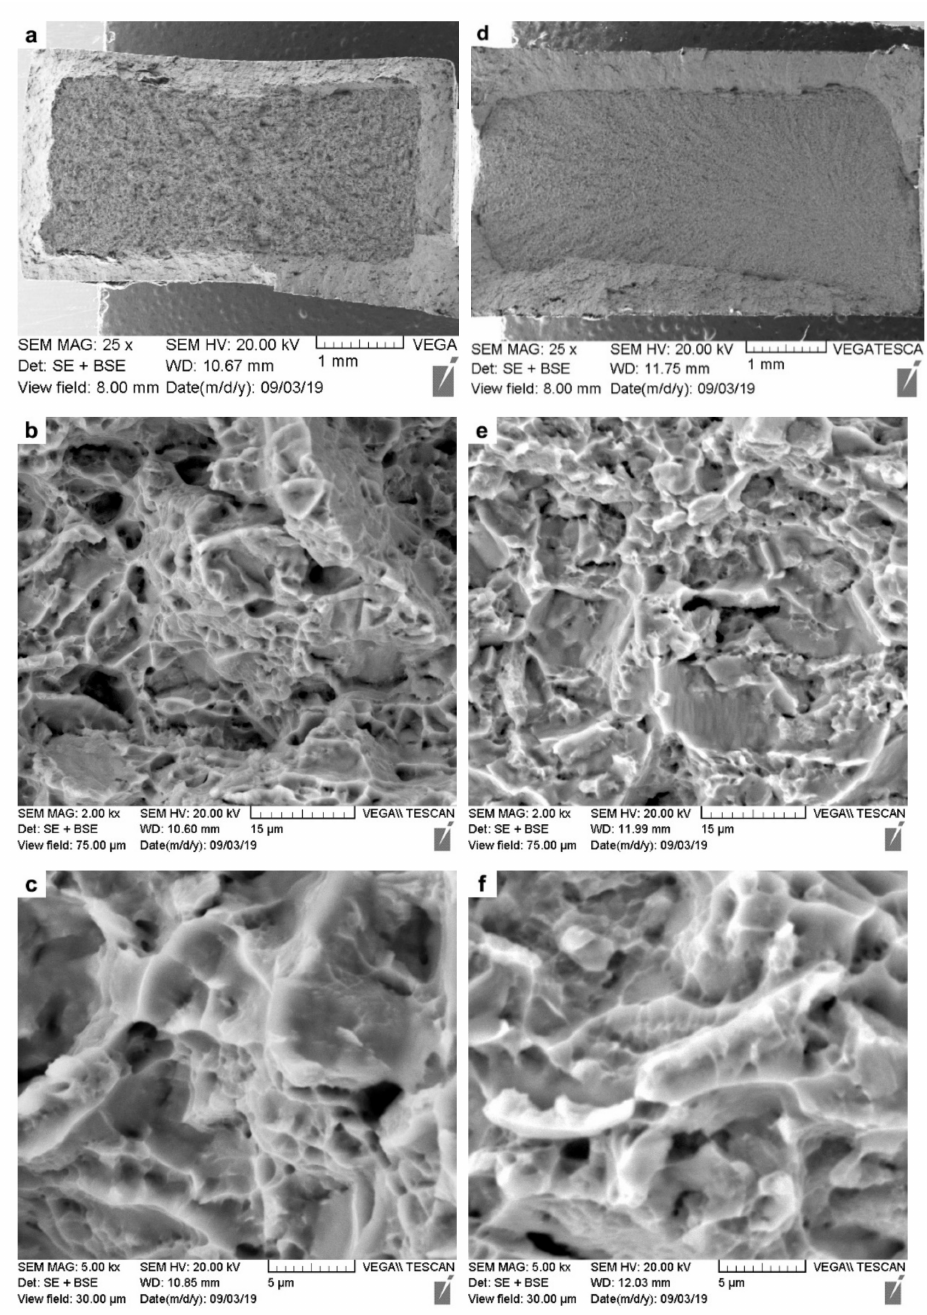
Figure 11. SEM images of the tensile fracture surfaces: ( a – c ) AWed; ( d – f ) SRAed. At high magnification, images of the fracture surfaces from the AWed (Figure 11b,c) and SRAed joints (Figure 11e,f) show evidence of ductile fractures with the presence of dim- ples that are a result of microvoid formation, growth, and coalescence. Specifically, in the absence of precipitates/inclusions, the mismatch in the strain hardening characteristics of α and β phases in Ti-6242 results in the α / β interfaces emerging as ubiquitous sites for the preferential nucleation of microvoids that then grow and coalesce into micro-pores/cracks. Extensive plastic deformation ahead of the crack tips gives rise to the dimple